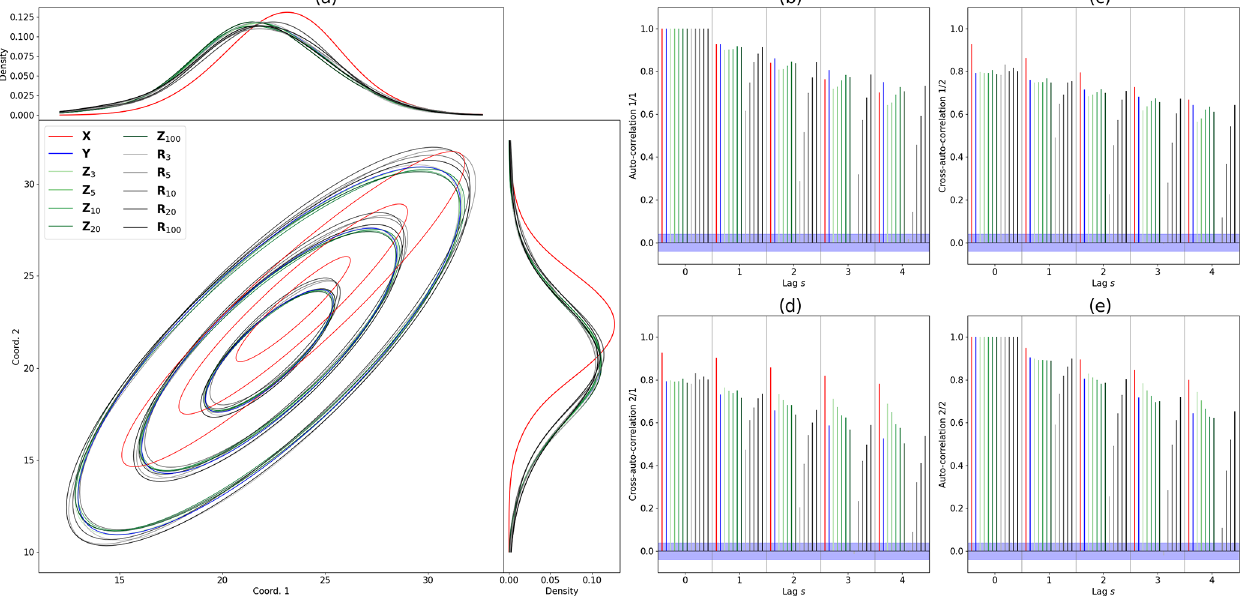
Figure 2. (a) Probability densities and covariance matrices of the VAR processes and their corrections. (b) Auto-correlation of the first coordinate. (c) Cross-auto-correlation between the first and the second coordinates. (d) Cross-auto-correlation between the second and the first coordinates. (e) Auto-correlation of the second